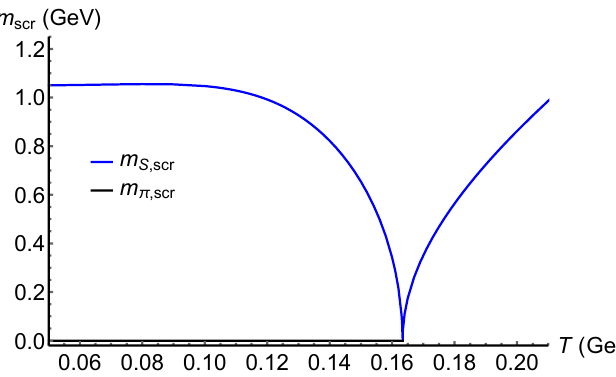
Figure 2 . The temperature dependence of the screening masses of the scalar meson ( m S , scr ) and the pion ( m π, scr ) in the chiral